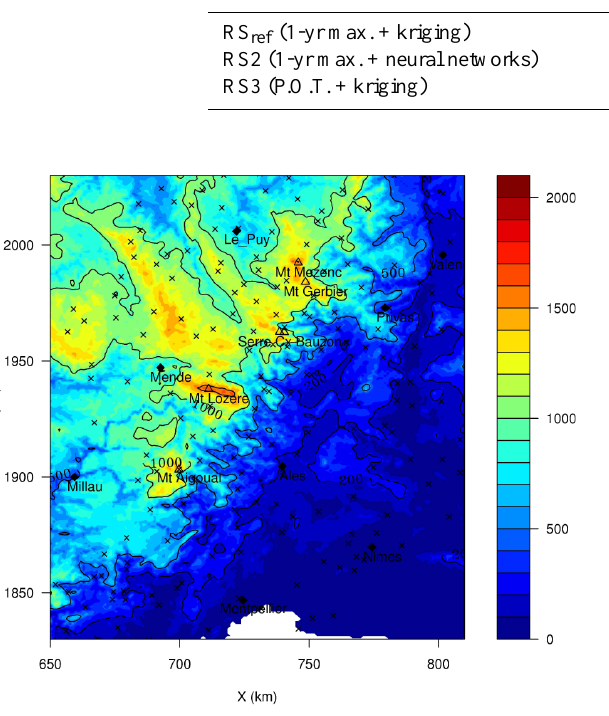
Fig. 5. Altitude map of the study region. The levels 200, 500 and 1000m are also represented as iso-contour lines. The crosses rep- resent the raingauge network composed by 225 daily gauges. Black diamonds represent cities, triangles the main mountain peaks.